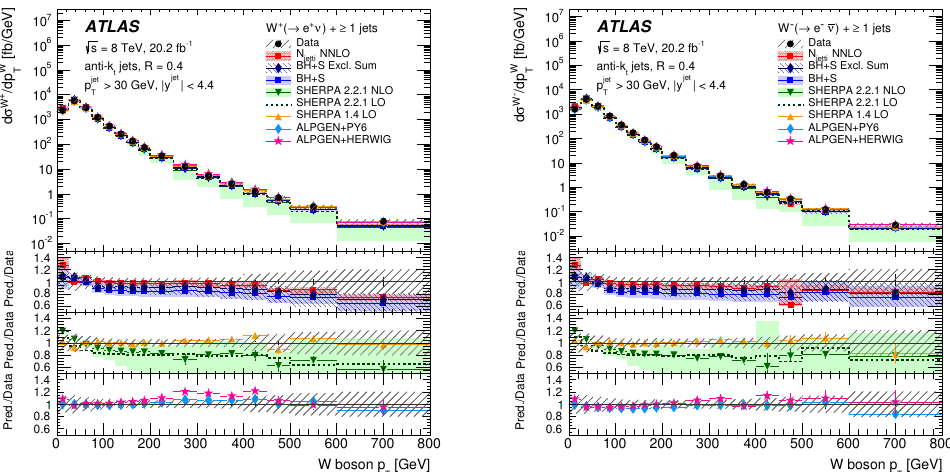
Figure 18 . Di(cid:11)erential cross sections for the production of W + (left) and W (cid:0) (right) as a function of the W p T for events with N jets (cid:21) 1. For the data, the statistical uncertainties are indicated as vertical bars, and the combined statistical and systematic uncertainties are shown by the hatched bands. The uppermost panel in each plot shows the di(cid:11)erential cross sections, while the lower panels show the ratios of the predictions to the data. The theoretical uncertainties on the predictions are described in the text. The arrows on the lower panels indicate points that are outside the displayed range.